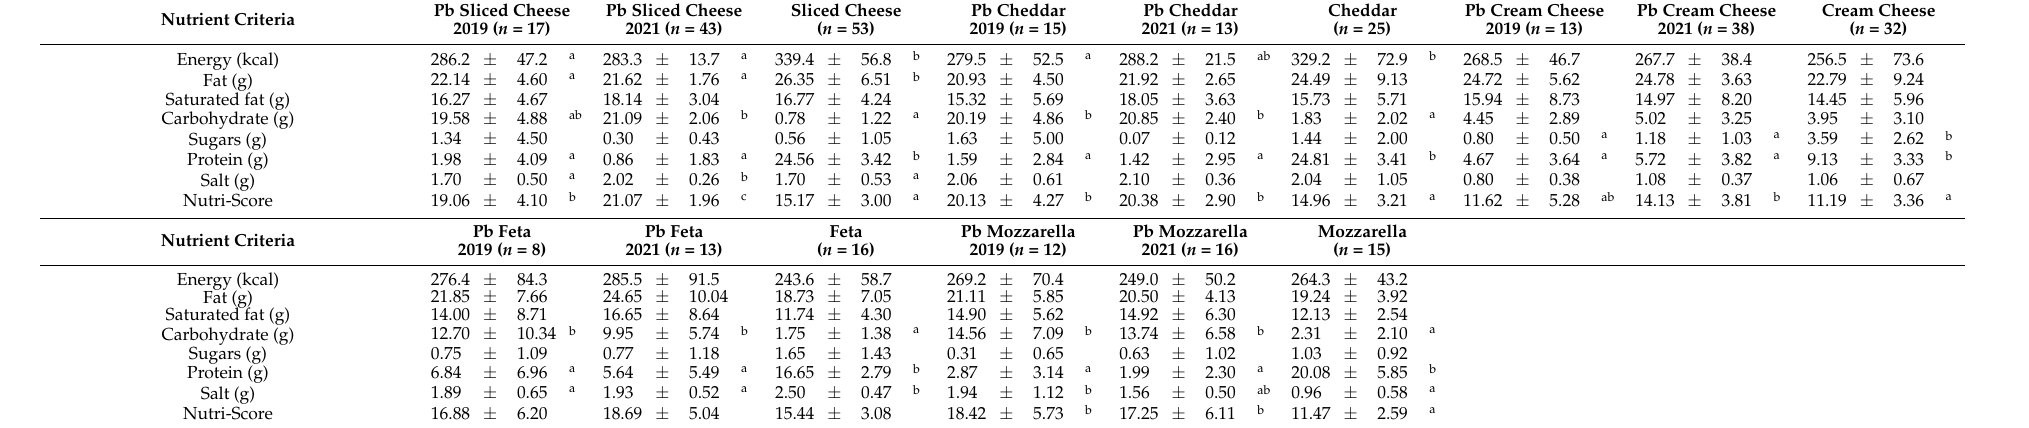
Table 6. Nutrients (“Big 7”) and Nutri-Score per 100 g of pb cheese alternatives and cheese (mean and standard deviation) in five different food groups, compared to animal-based products